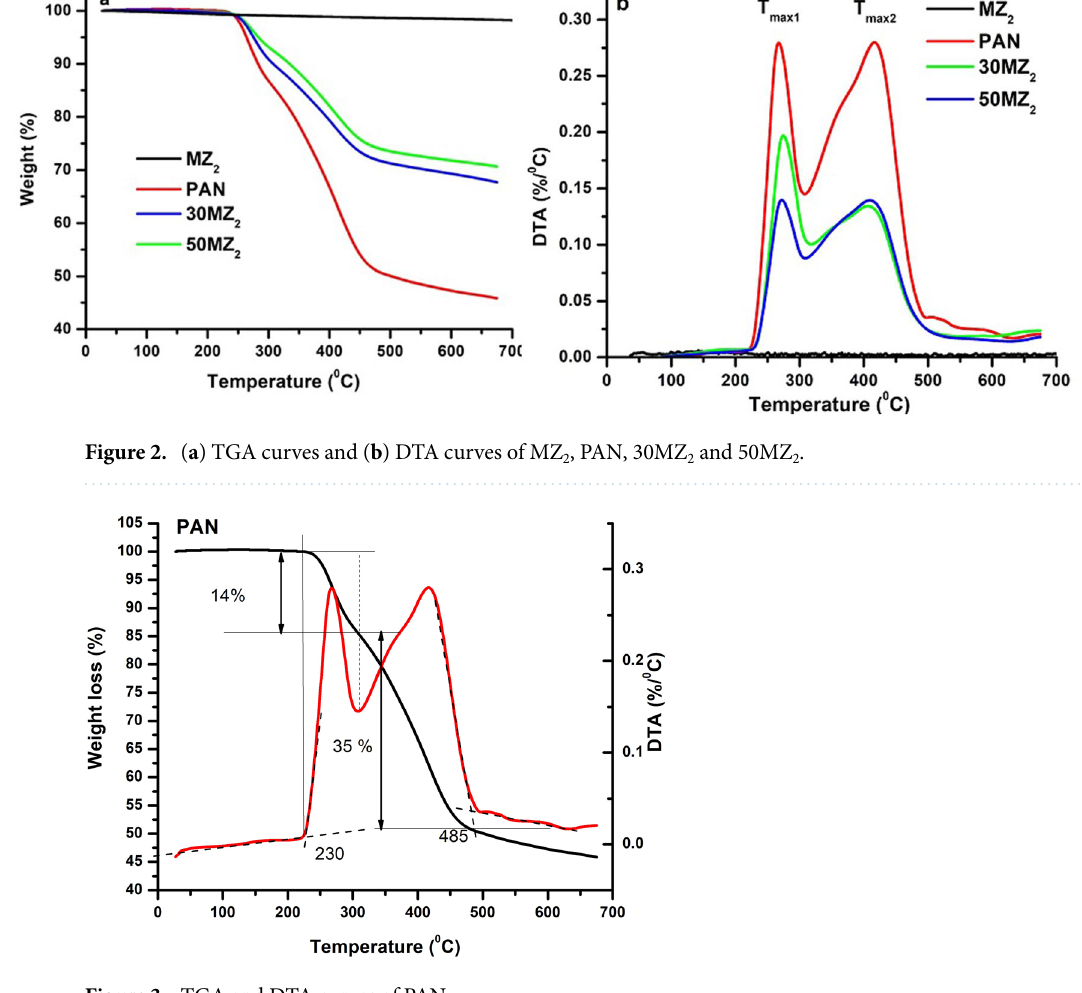
Figure 3. TGA and DTA curves of PAN.